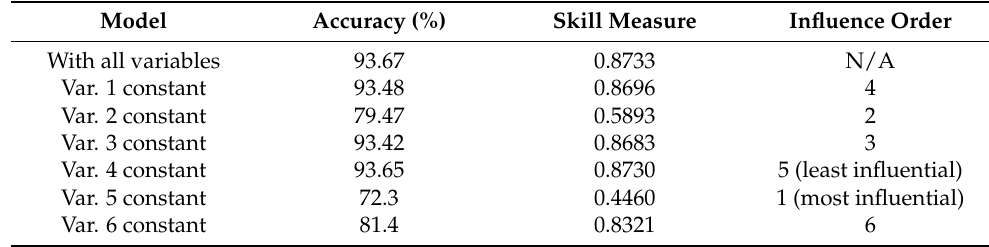
Table 3. The outcome of forcing a single independent variable to be constant when testing the transition from bare land to urban land.